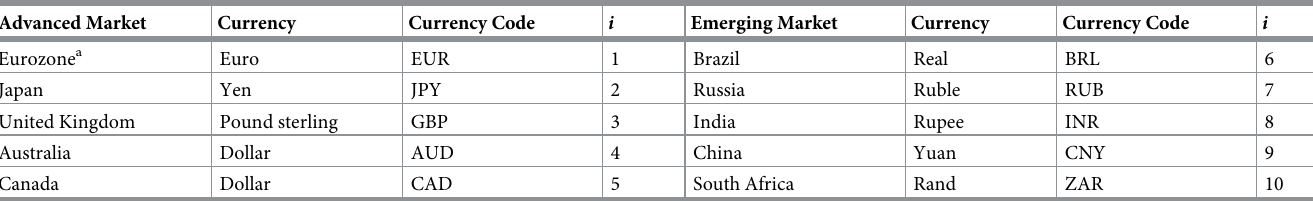
Table 1. Ten markets and their